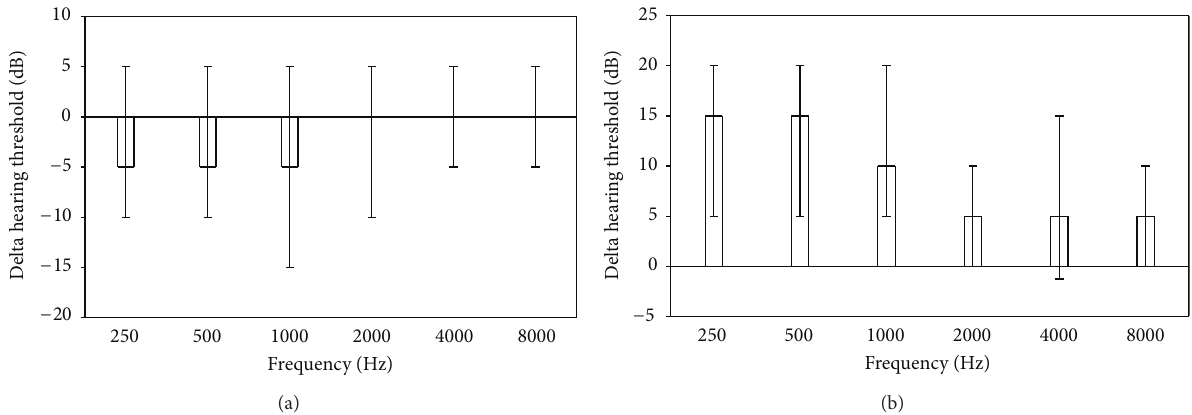
Figure 2: (a) Changes in hearing threshold 28 days after start of treatment of uncomplicated malaria relative to threshold before treatment (median, 25% and 75% quartiles). Hearing improvement compared with day 0 was significant at wavelengths 250 Hz and 500 Hz and for left ear also 1000Hz (signed rank test performed for each frequency and ear, 𝑃 < 0.05 , 𝑛 = 47 ). (b) Changes in hearing threshold 28 days after start of treatment of uncomplicated malaria relative to threshold at follow-up 9–12 months later. Hearing was significantly impaired on day 28 as compared with followup at all wavelengths and both ears (signed rank test, 𝑃 < 0.01 , 𝑛 = 38 ).